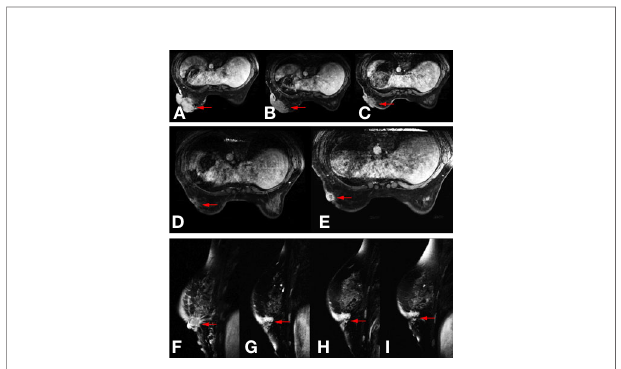
FIGURE 1 | Images of mammary magnetic resonance imaging (MRI) in different phases. (A) The baseline mammary magnetic resonance imaging (MRI) in November 2017. (B) Mammary MRI after fi ve cycles of TCbH regimen in February 2018. (C) Mammary MRI after four cycles of ECH regimen in May 2018. (D) Mammary MRI after two cycles of nab-paclitaxel plus trastuzumab regimen in July 2018. (E, F) Mammary MRI after four cycles of nab-paclitaxel plus trastuzumab regimen in August 2018. (G) Mammary MRI after two cycles of pyrotinib plus capecitabin regimen in October 2018. (H) Mammary MRI after four cycles of pyrotinib plus capecitabin regimen in November 2018. (I) Mammary MRI after six cycles of pyrotinib plus capecitabin regimen in December